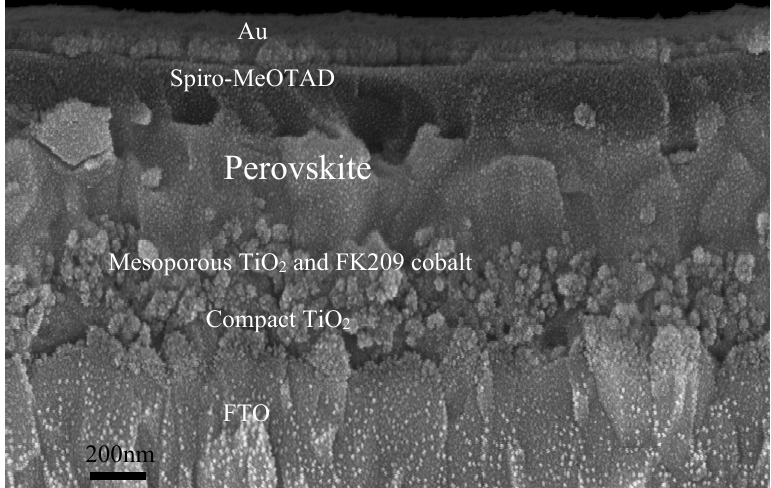
Figure 11. An SEM image of the cross-section of the perovskite solar cell device fabricated in this study showing the different layers.